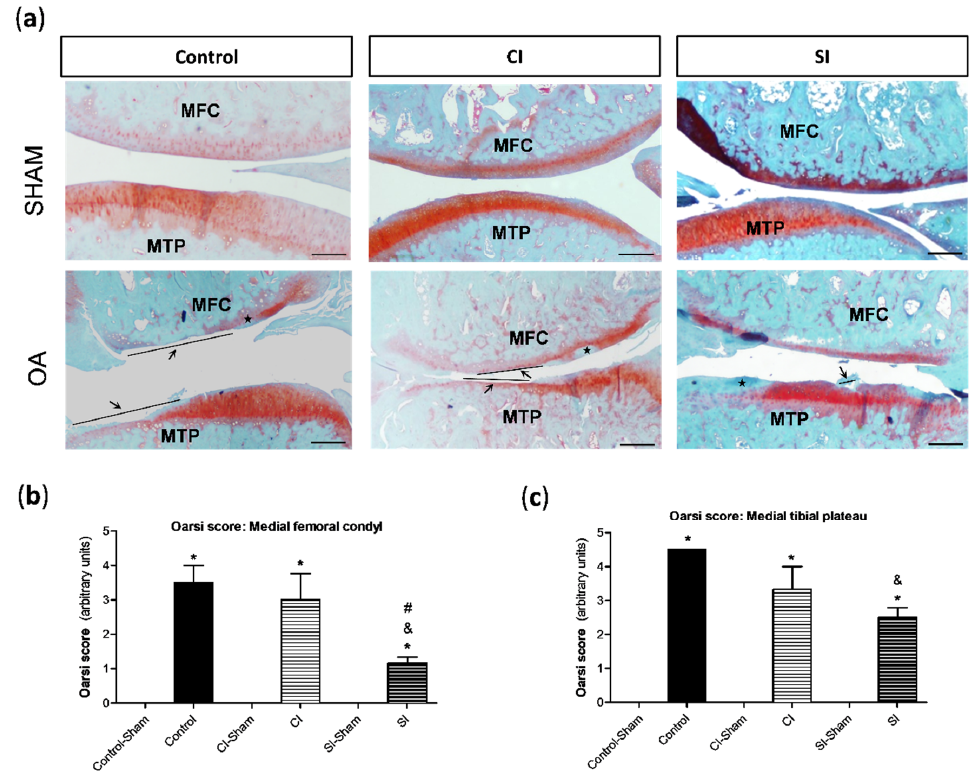
Figure 3. Histological analysis of articular cartilage. Cartilage lesions were evaluated by the semi-quantitative modified osteoarthritis Research Society International (OARSI) score, as previously indicated in the Materials and Methods section. ( a ) Representative images of the joint sections stained with Safranin-O-fast green from each group of the study, showing the cartilage of the medial compartment from the tibial plateau (MTP) and femoral condyle (MFC) in the right knee (sham surgery) and left knee (OA surgery). Arrows indicate areas with a loss of cartilage matrix and ★ indicates cartilage with the loss of Safranin staining (indicator of proteoglycan content). Analysis of the semi-quantitative score of the pathological alterations in the cartilage from MFC ( b ) and MTP ( c ). Values are mean ± SEM ( n = 3 independent animals for each condition). * p ≤ 0.05 vs. the respective sham-operated joint; & p ≤ 0.05 vs. the C group; # p ≤ 0.05 vs. the CI group. Control, non-treated; CI, control injection; SI, H 2 S donor injection. Scale bar = 500 µm.